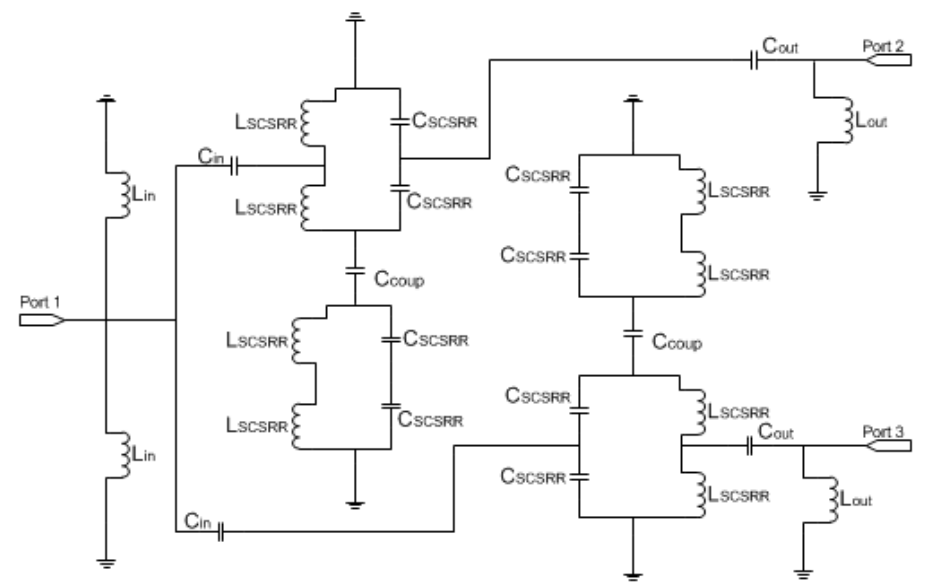
Figure 23. Equivalent circuit model for the multilayer stripline diplexer.